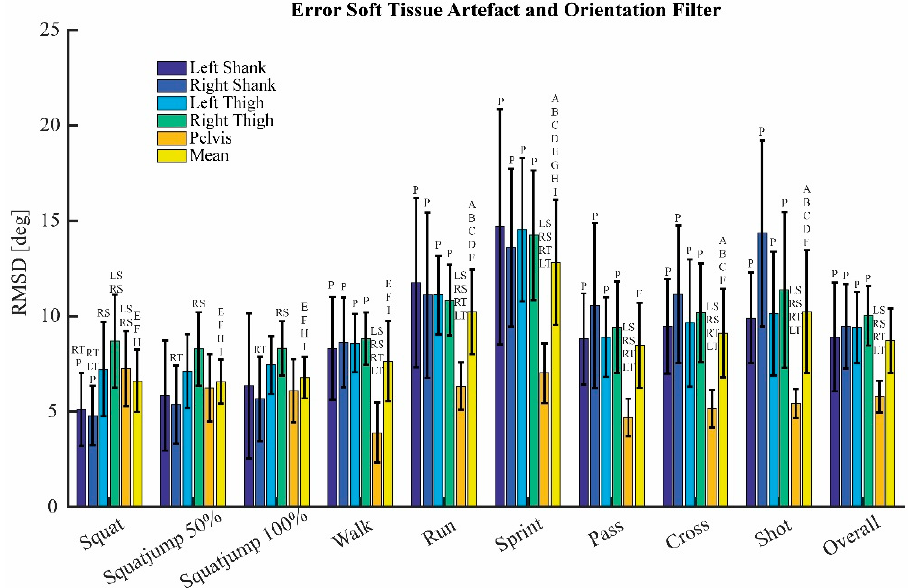
Figure A3. Combined error of the soft tissue artefact and the orientation filter. Mean root-mean- square differences (RMSD) and standard deviations for all body segments and all trials. Significant differences within each trial between body segments are displayed by letters above the bar, LS, RS, LT, RT, and P mean a significant difference with the left shank, right shank, left thigh, right thigh, and pelvis, respectively. Significant differences between trails are displayed with a letter above the mean bar. A = squat, B = squat jump 50%, C = squat jump 100%, D = walk, E = run, F = sprint, G = pass, H = cross and I =